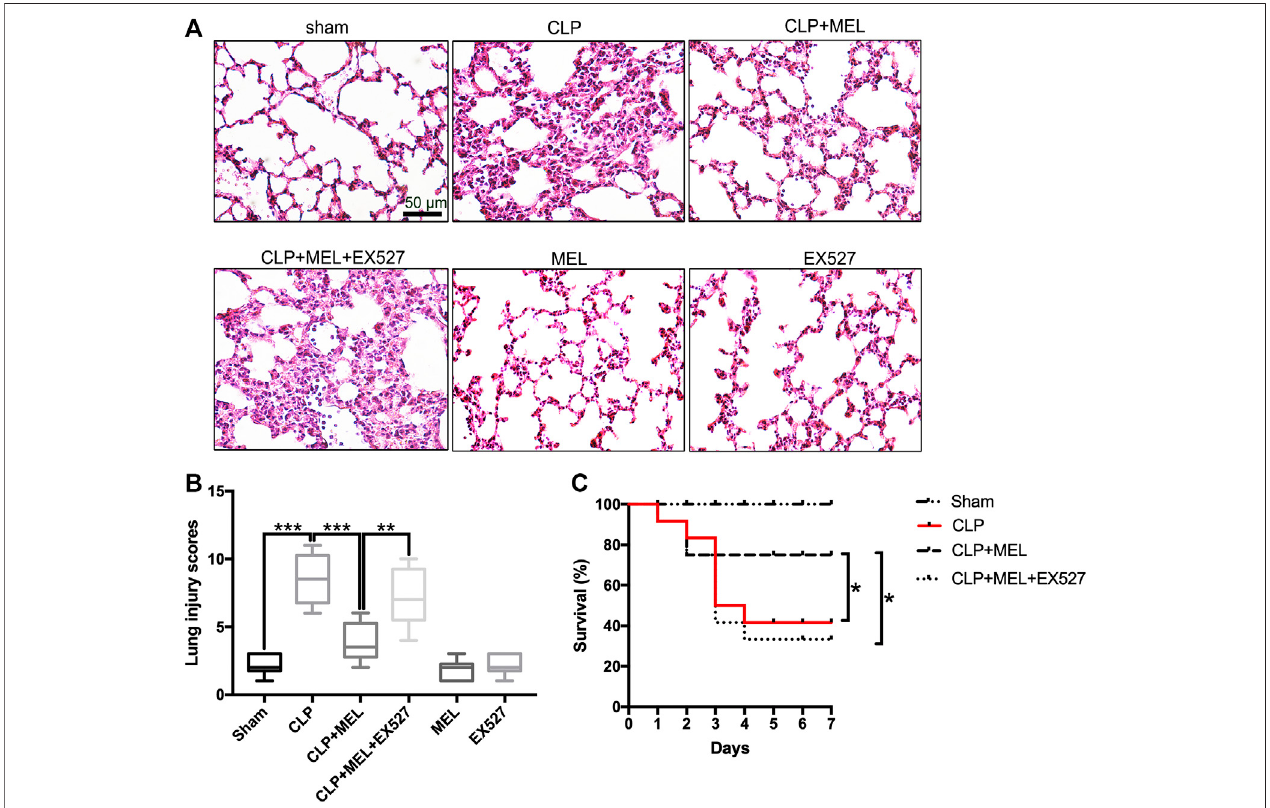
FIGURE 2 | Melatonin protected against lung injury in CLP-induced ALI. Mice were administrated with melatonin 30 mg/kg daily by intraperitoneal injection for 3 days before CLP or sham operation, on the fourth day mice received one dose of melatonin 1 h before CLP operation. EX527 was prepared in phosphate-buffered saline for a single intravenous (5 μ L) injection 1 h before administration of melatonin. At 24 h after CLP surgery, the effect of melatonin on lung injury was assessed by (A) histology. (B) Lung damage scores were calculated according to the severity of lung injury. Data were presented as medians and ranges (5th-95th percentile). KruskalWallistestwasusedtoevaluatethedifferencesamonggroups.n (cid:1) 8,*** p < 0.001;** p < 0.01;* p < 0.05. (C) Micesurvivalratealsowasdetermined,n (cid:1) 12,*** p < 0.001; ** p < 0.01; * p < 0.05 (Pairwise log-rank test).